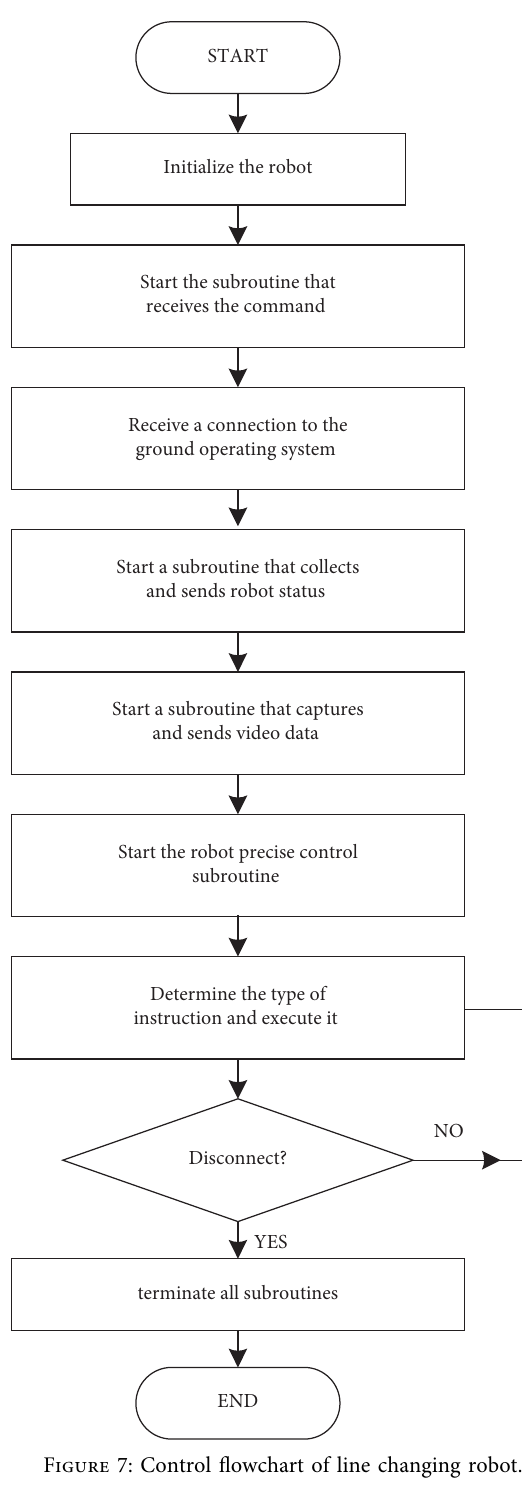
Figure 7: Control flowchart of line changing